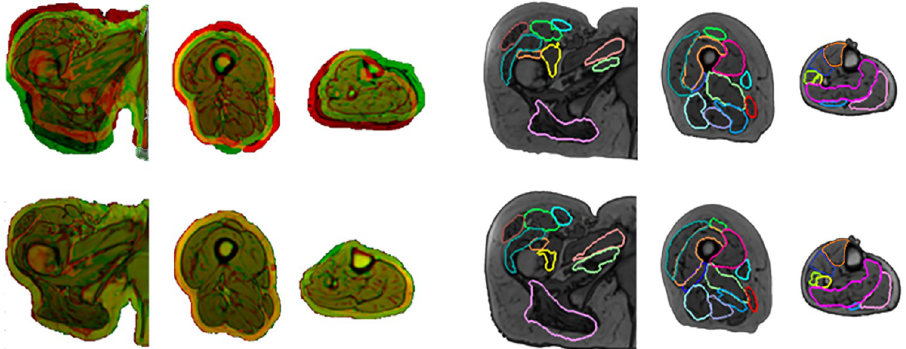
Fig 4. Qualitative interpretation of segmentation results. Registration and segmentation results from the combination of subjects resulting in the median average DSC (subject 4 and 2 as the target and reference, respectively). The registration inputs (top row) and outputs (bottom row) for these combinations of subjects are shown on the group of images on the left. The segmentation results are shown in the right three image groups, where the reference and automatic segmentations for the target subject are shown in blue and red respectively. The muscles that are not highlighted within the images, were found not to be segmented with an appropriate level of repeatability.